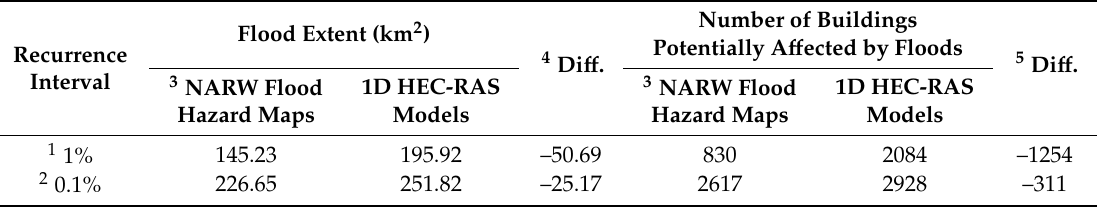
Figure 11. Comparison between official flood extent provided by NARW for the 0.1% (1000-year) recurrence interval probability and 1D HEC-RAS flood extent for the 0.1% (1000-year) recurrence interval probability. The significant differences recorded within the lower sector of the Jijia floodplain are highlighted for sections ( a , b ). Table 5. Comparison between flood extent and total number of buildings potentially affected by floods based on NARW flood hazard maps and 1D HEC-RAS scenarios computed for 1% (100-year) and 0.1% (1000-year) recurrence intervals.